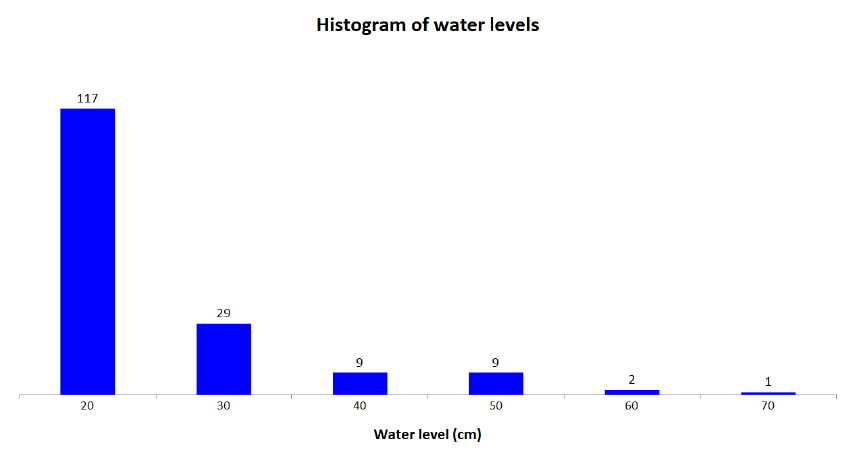
Figure A4. Even though the heavy rain just occurred during a few hours (3:00–5:00 p.m.), simulation results show that there are 50 points where water levels are from 30 to 70